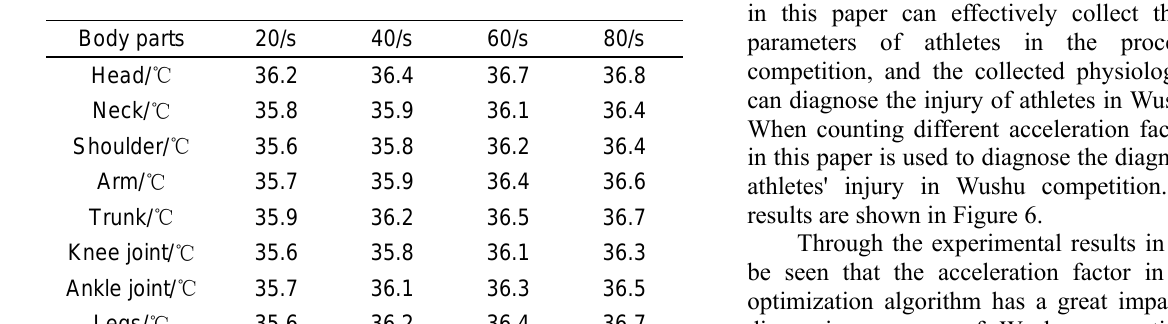
Table 2. Temperature collection results of martial arts athletes